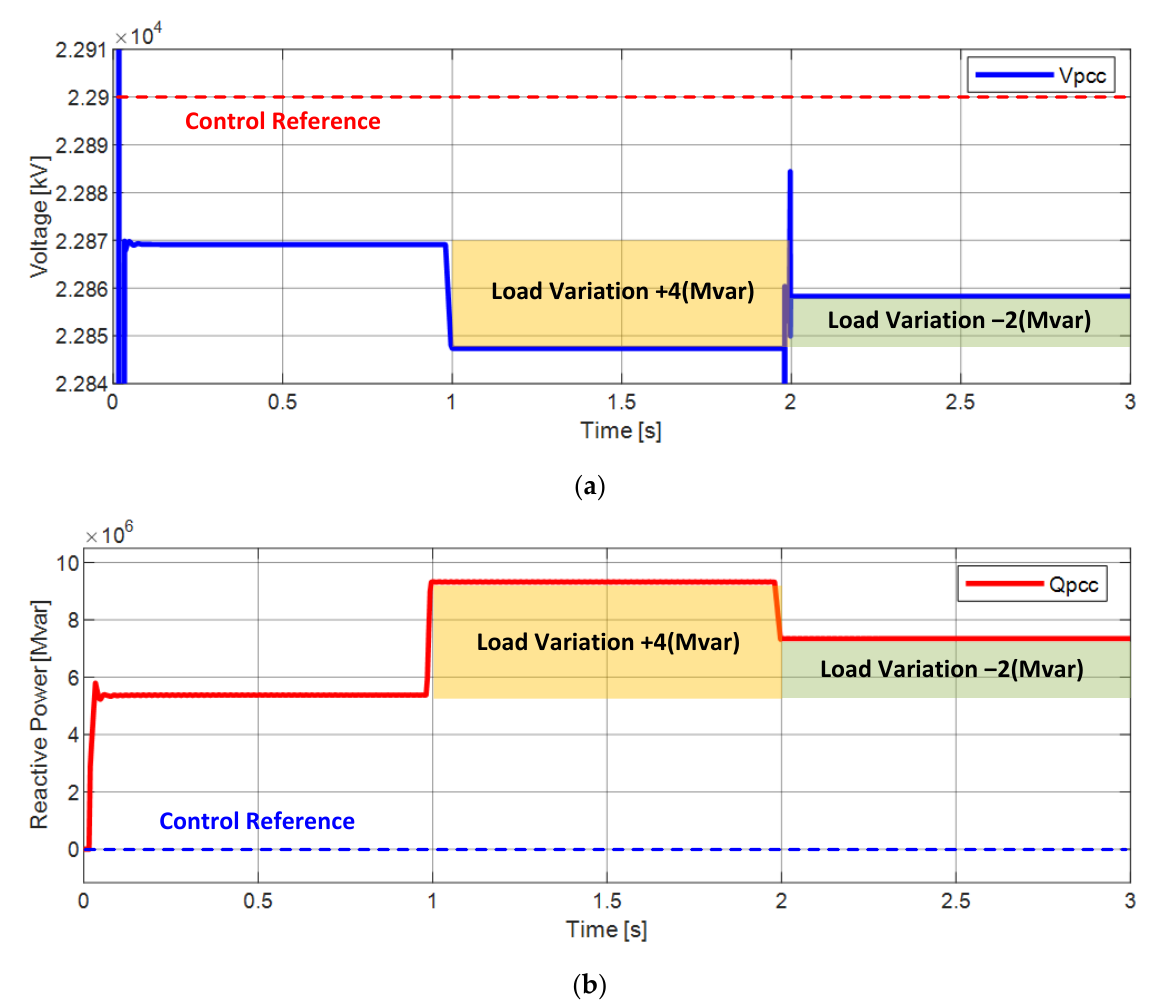
Figure 9. PCC Variation according to the Load Variation of Virtual STATCOM (Before Compensation by Algorithm) ( a ) PCC Voltage, ( b ) PCC Reactive Power.